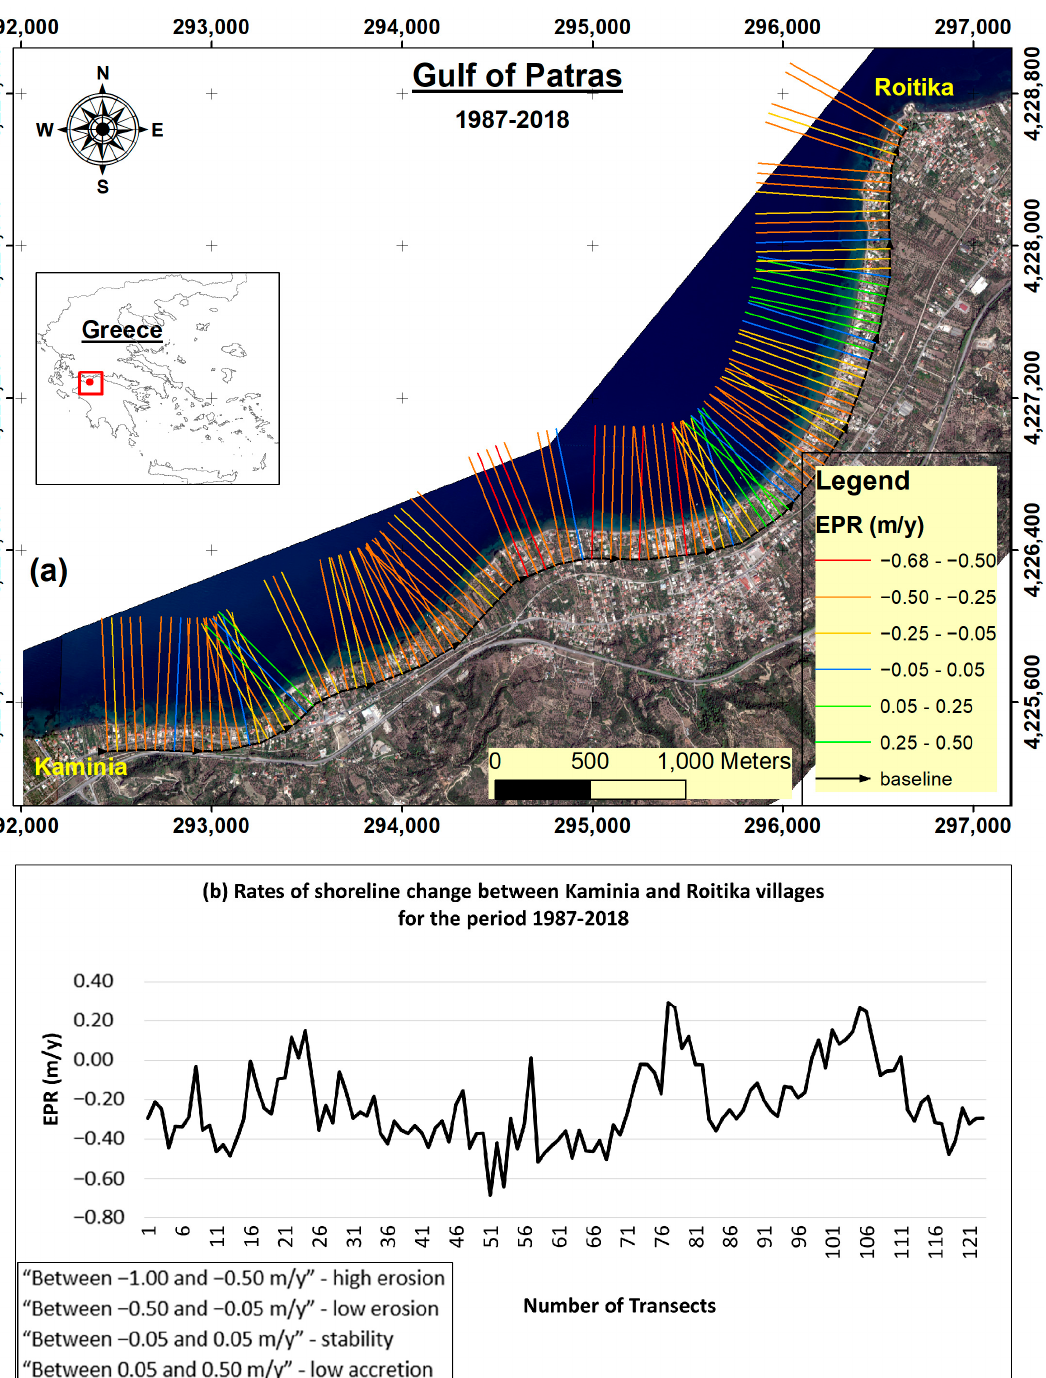
Figure 11. ( a ) Map showing the statistical EPR transects and ( b ) line graph showing the EPR values (mm/y) of each transect between Kaminia and Roitika villages for the period 1987–2018.